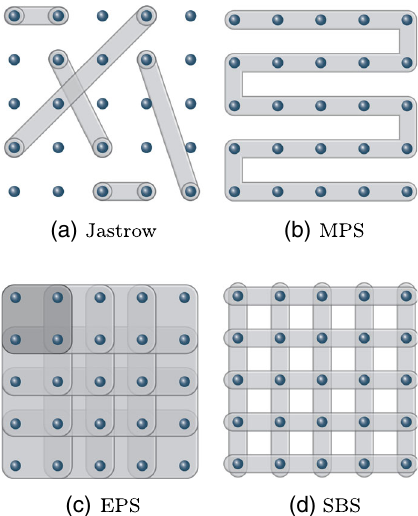
FIG. 1. Geometry of Ansatz wave functions: (a) Jastrow wave functions include correlations within all pairs of spins. (b) MPS in 2D cover the lattice with one snake. (c) EPS include all spin correlations within each plaquette ( 2 × 2 on the figure) and mediate correlations between distant spins through overlapping plaquettes. (d) SBS cover the lattice with many 1D strings on which the interactions within spins are captured by a